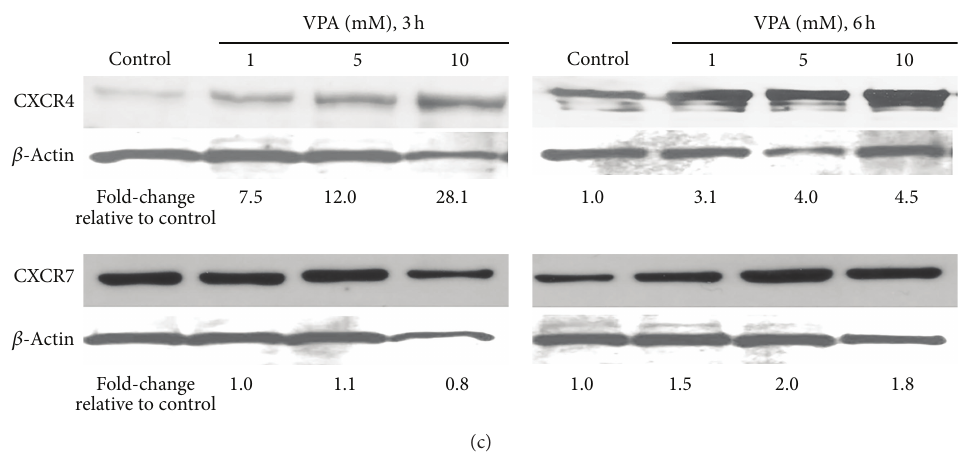
Figure 1: VPA increases CXCR4 and CXCR7 gene and protein expression. CB-derived MSC were treated with 0 (control), 1, 5, or 10mM of VPA for 3 or 6h. (a) Expression of CXCR4 and CXCR7 mRNAs was evaluated by real-time quantitative RT-PCR using 18S mRNA as internal calibrator. The data shown are based on two independent experiments. ∗ 𝑃 < 0.05 indicates statistically significant difference relative to control. (b) Surface expression of CXCR4 and CXCR7 was not affected by VPA treatment as determined by flow cytometry. The black line represents isotype control, the red line is for CXCR4, and the green line is for CXCR7. (c) Western blot of total CXCR4 and CXCR7 protein using 𝛽 -actin as loading control. The numbers at the bottom of the gels represent the fold-increase in expression after VPA treatment relative to control. The data is representative of three independent experiments.